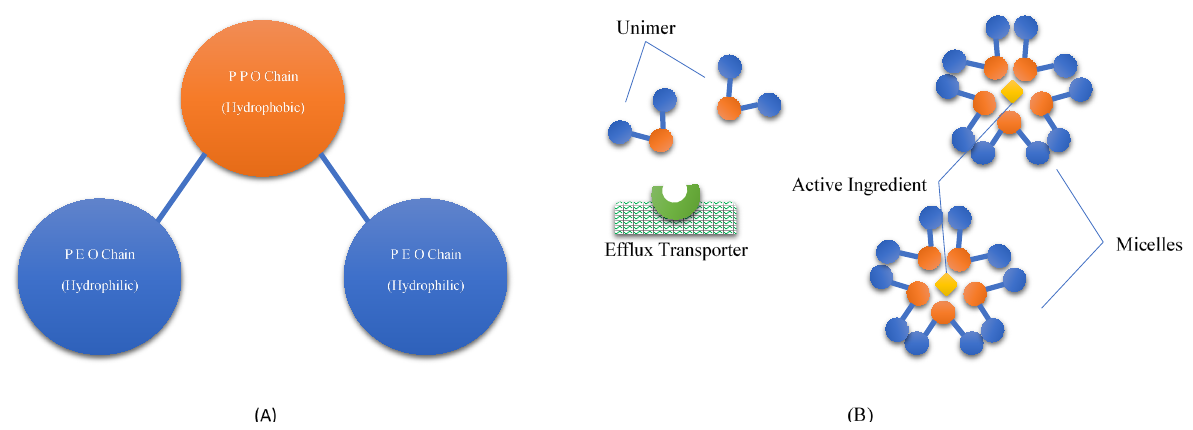
FIGURE 1 - Illustration of the poloxamer structure, which is a triblock copolymer (A); Illustration of contradictory conditions where the poloxamer must be in the form of a unimer to be able to inhibit the efflux pump while it must be in the form of a micelle to be able to dissolve the active ingredient